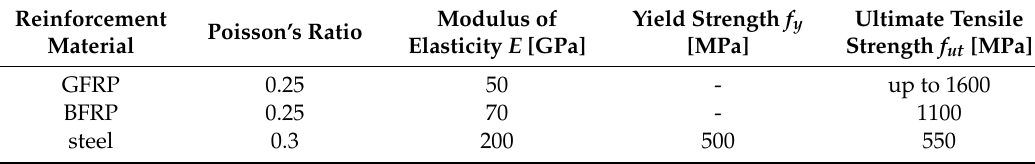
Table 2. Mechanical characteristics of longitudinal reinforcement materials [2,28].